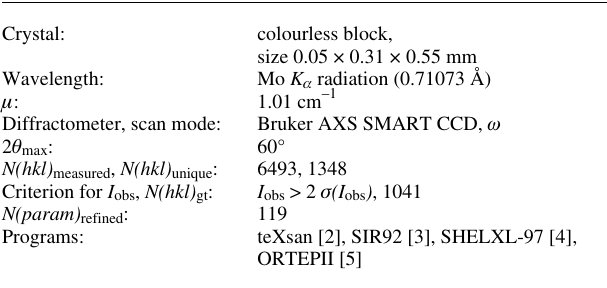
Table 1. Data collection and handling.